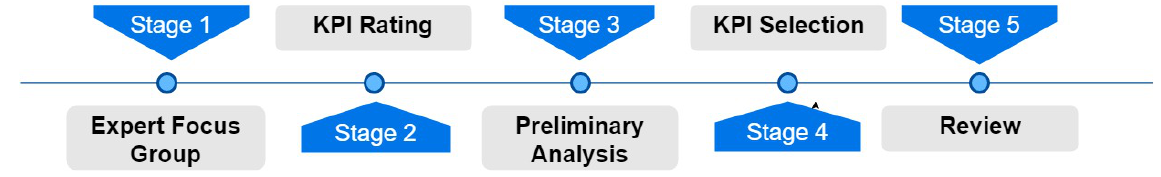
Figure 1. 5-stage assessment method for KPI